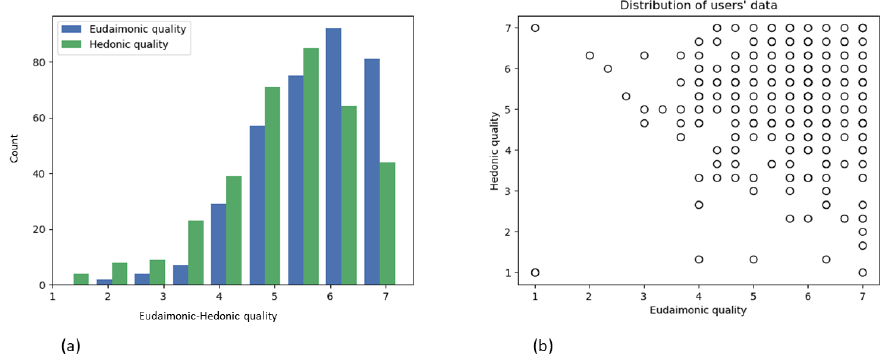
Figure 3. The distribution of users: ( a ) histogram of hedonic (blue) and eudaimonic (green) values and ( b ) eudaimonic vs. hedonic